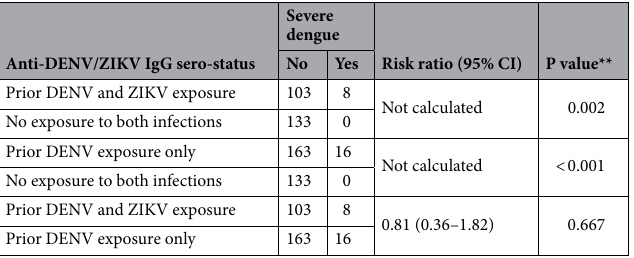
Table 5. Association between previous DENV/ZIKV exposure and severe dengue* during the current DENV infection. *Define according to WHO 2009 clinical classification of dengue. **Calculated as two-tailed p value with Fisher’s exact